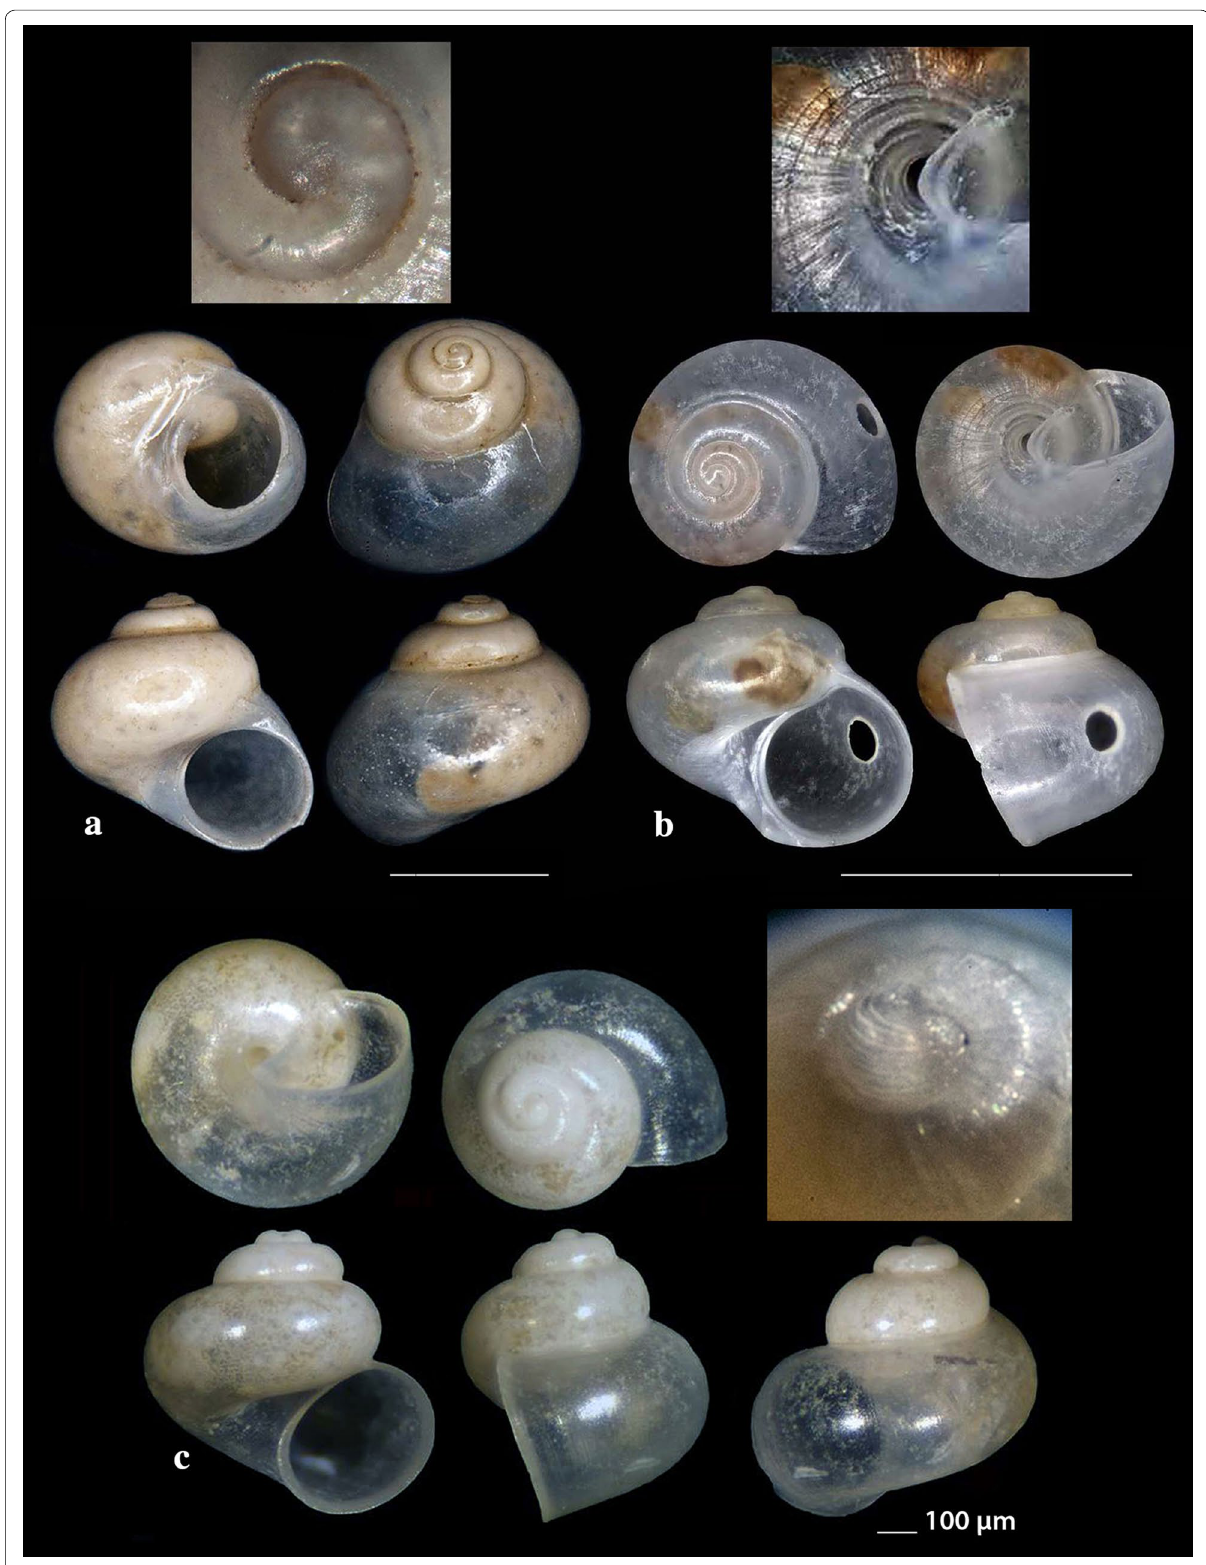
Fig. 4 a , b Cirsonella romettensis , c Lissomphalia bithynoides. Bar